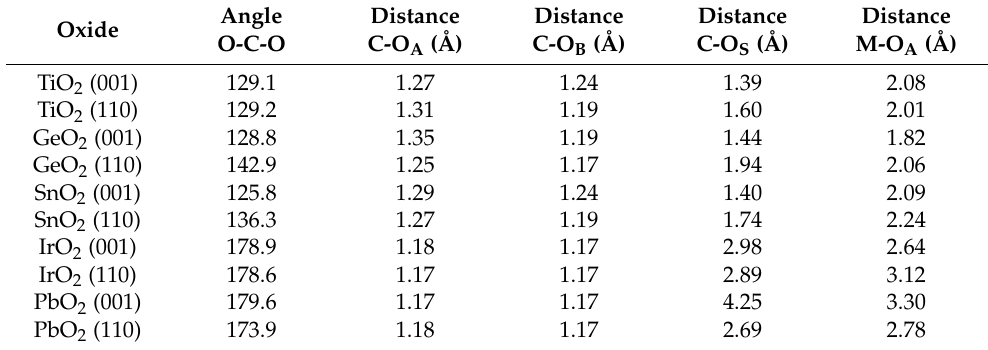
Table 2. Distances and angles of the adsorption geometries for TiO 2 , GeO 2 , SnO 2 , IrO 2 and PbO 2